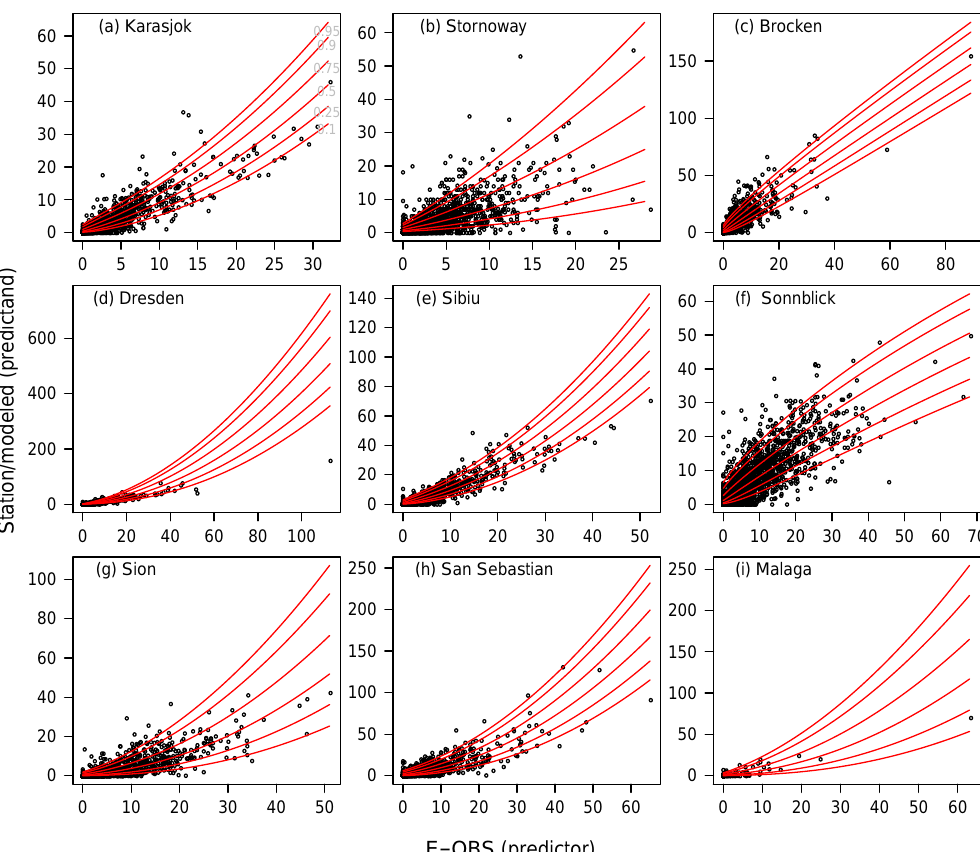
Figure B3. Step 2: downscaling. Estimated relation between gridded and point-scale precipitation observations for example stations in JJA. VGLM gamma where both parameters depend on the predictor fitted to observed wet day intensities. The predictor is E-OBS. Cir- cles: observed precipitation intensities (mmday − 1 ); lines: 0.1, 0.25, 0.5, 0.75, 0.9, and 0.95 modeled quantiles (mmday − 1 ). (a) Karasjok, (b) Stornoway, (c) Brocken, (d) Dresden, (e) Sibiu, (f) Sonnblick, (g) Sion, (h) San Sebastian, and (i)